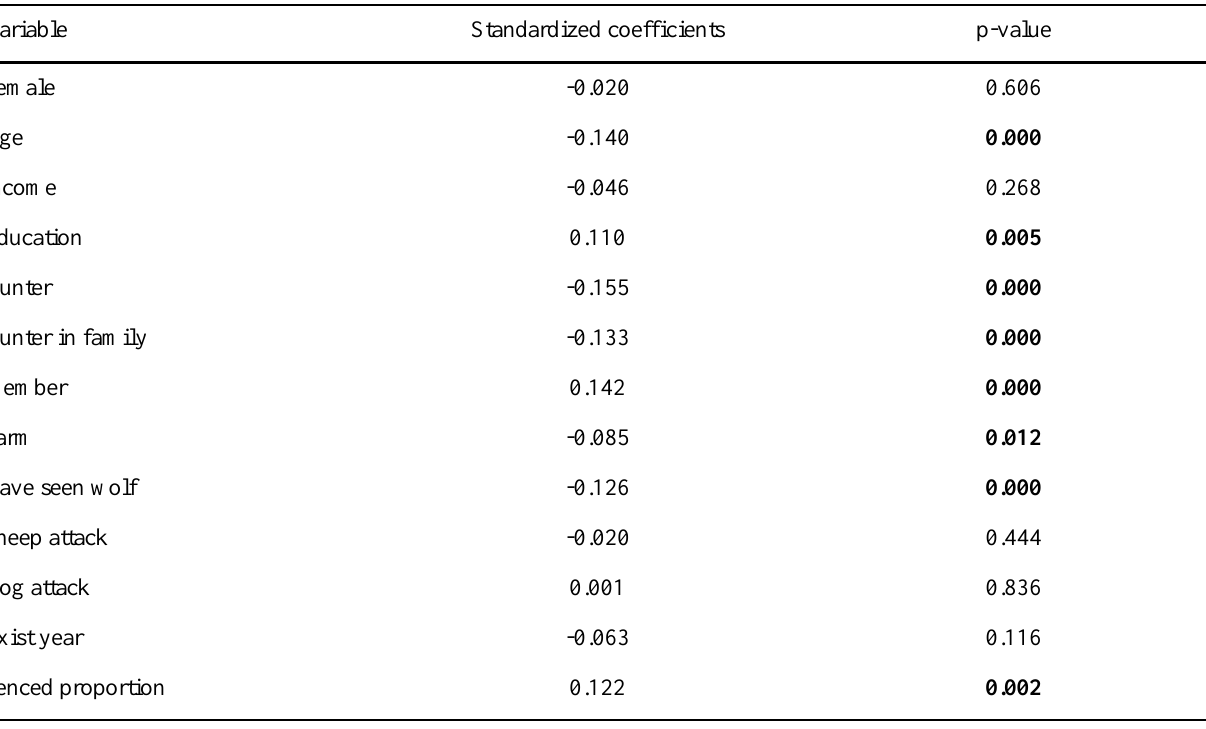
Table 4. Parameter estimates for the attitude model. A negative sign on the parameter implies negative effect on the dependent variable when the independent variable